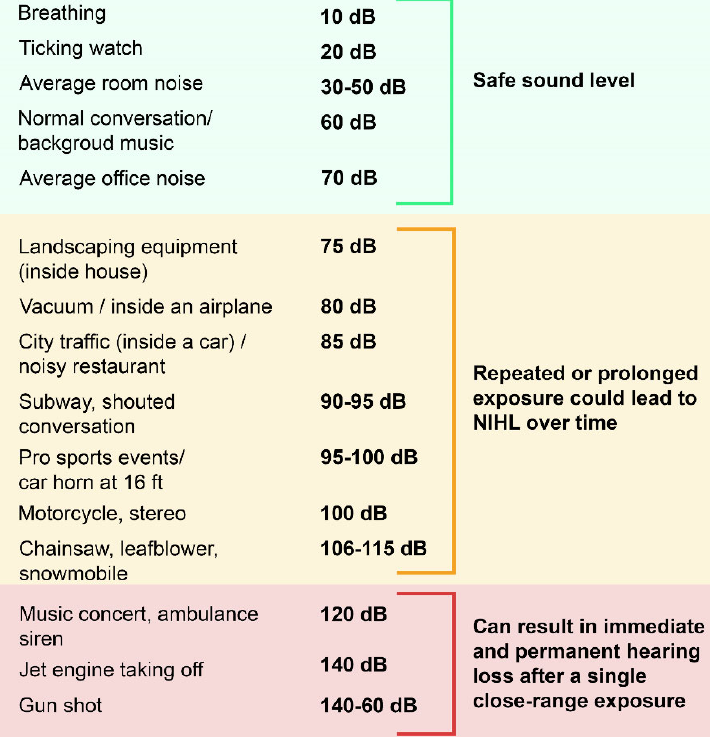
Figure 1. Examples of noise exposure levels in occupational and non ‐ occupational settings.